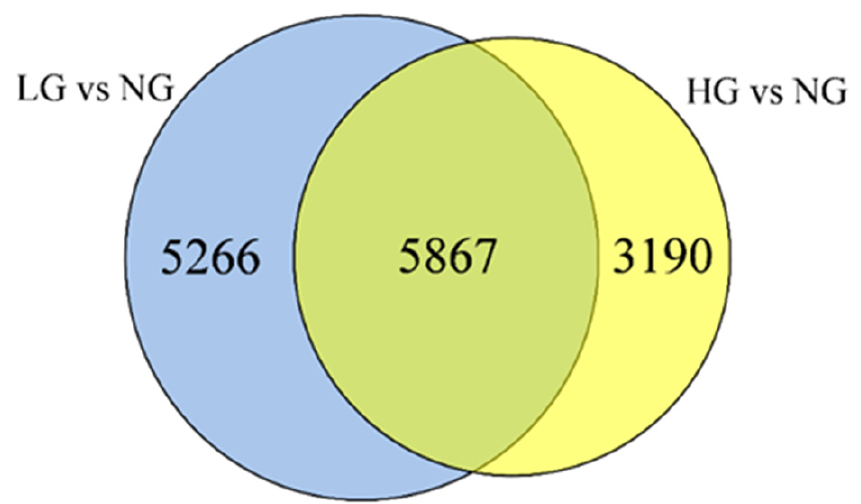
Figure 7. Venn diagram of the functional annotation where each number represents the number of genes in different databases. Blue shows DEGs in light grazing vs non − grazing, light yellow shows DEGs in heavy grazing vs non − grazing, deep yellow indicates co-expression DEGs in two treats.